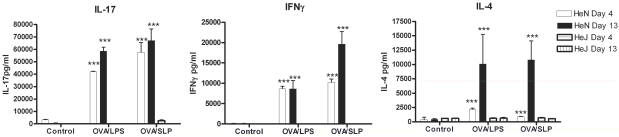
DCs activated by SLPs induce T helper responses.DCs isolated from C3H/CheN or C3H/CheJ mice were incubated with LPS (100 ng/mL) or SLPs (20 µg/mL) in the presence of OVA peptide (5 µg/mL) for 24 h. After 24 h DC (2×105/mL) were irradiated and added to CD4+ T cells (2×106/mL) purified from the spleens of OVA D011.10 mice. Supernatants were removed on Day 4. Fresh SLP/OVA- or LPS/OVA-treated DC were added on Day 7, together with rIL-2 (10 U/mL). Supernatants were removed on Day 10, and analysed for IFNγ, IL-17, and IL-4 using ELISA. Results are means (± SEM) of n = 3 and represent two independent experiments. *** p<0.001, determined by one-way ANOVA test comparing all groups.